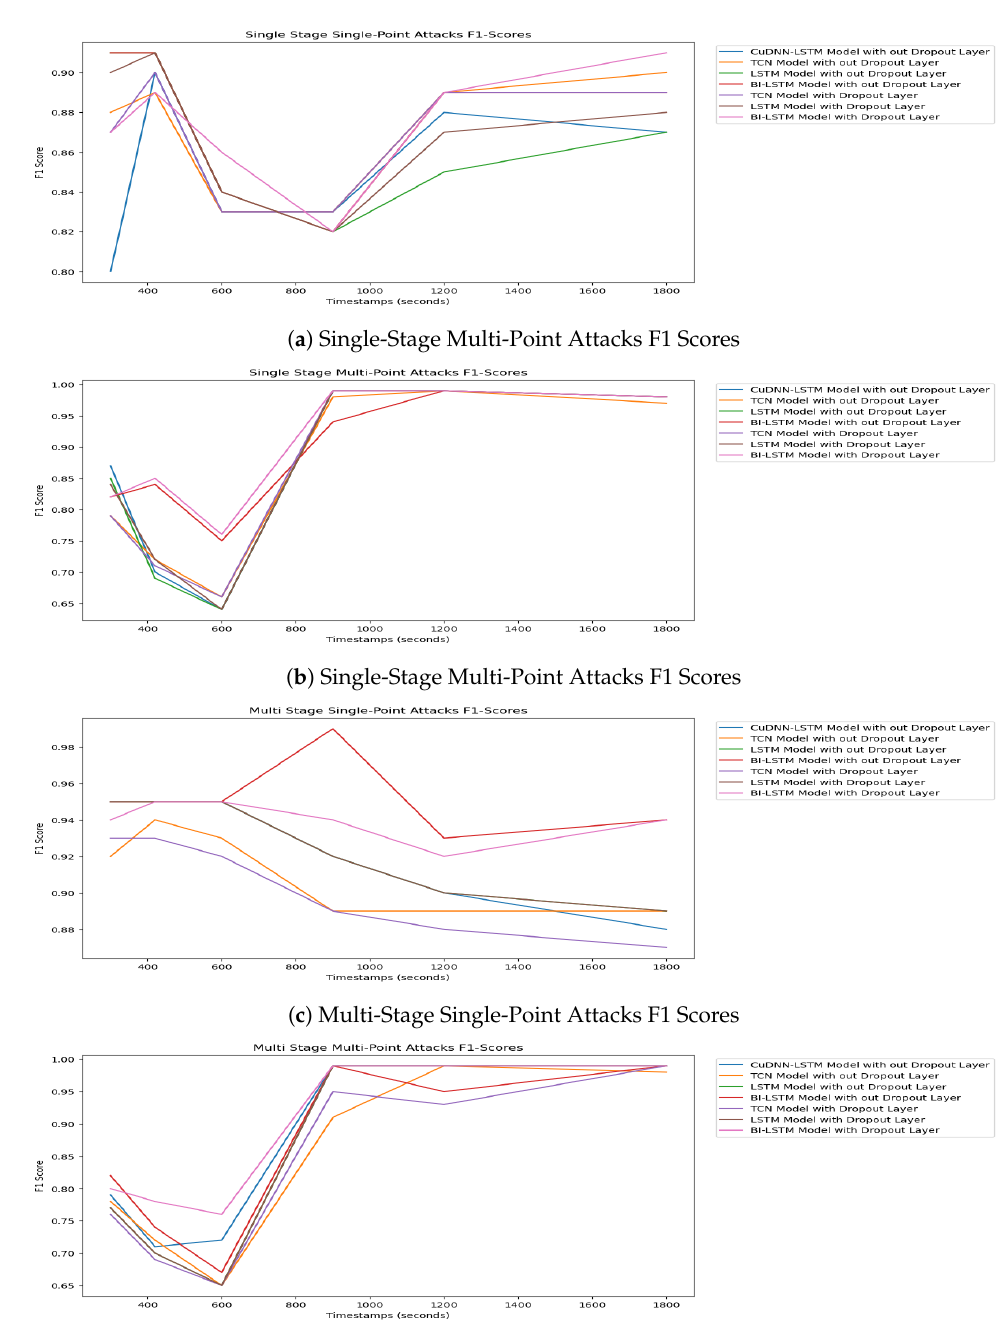
Figure 6. Single-Stage Single-Point Attacks, Single-Stage Multi-Point Attacks, Multi-Stage Single- Point Attacks and Multi-Stage Multi-Point Attacks F1